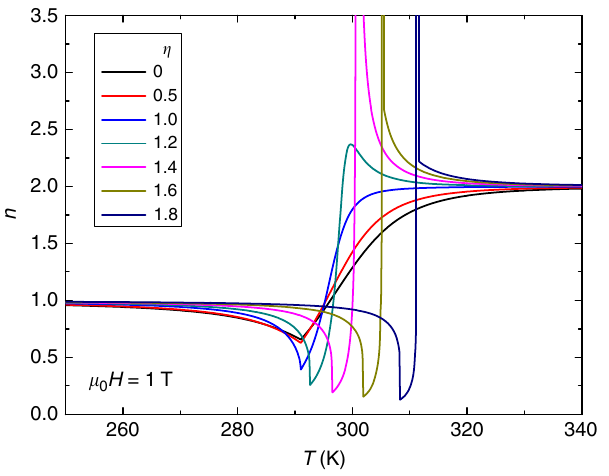
Fig. 5 Exponent n for the Bean and Rodbell model. Temperature dependence of the fi eld exponent of the magnetic entropy change for cases ranging from SOPT ( η ≤ 1) to FOPT ( η > 1) shows that values above values of the smallest η > 1 value for which the overshoot is apparent. Likewise, in the case of experimental samples, the fi ne details of the phase transition will also dictate when the fi rst order nature of the transition is detectable beyond the experimental noise. This is not a limitation of the currently proposed criterion but intrinsic to any experimental method.